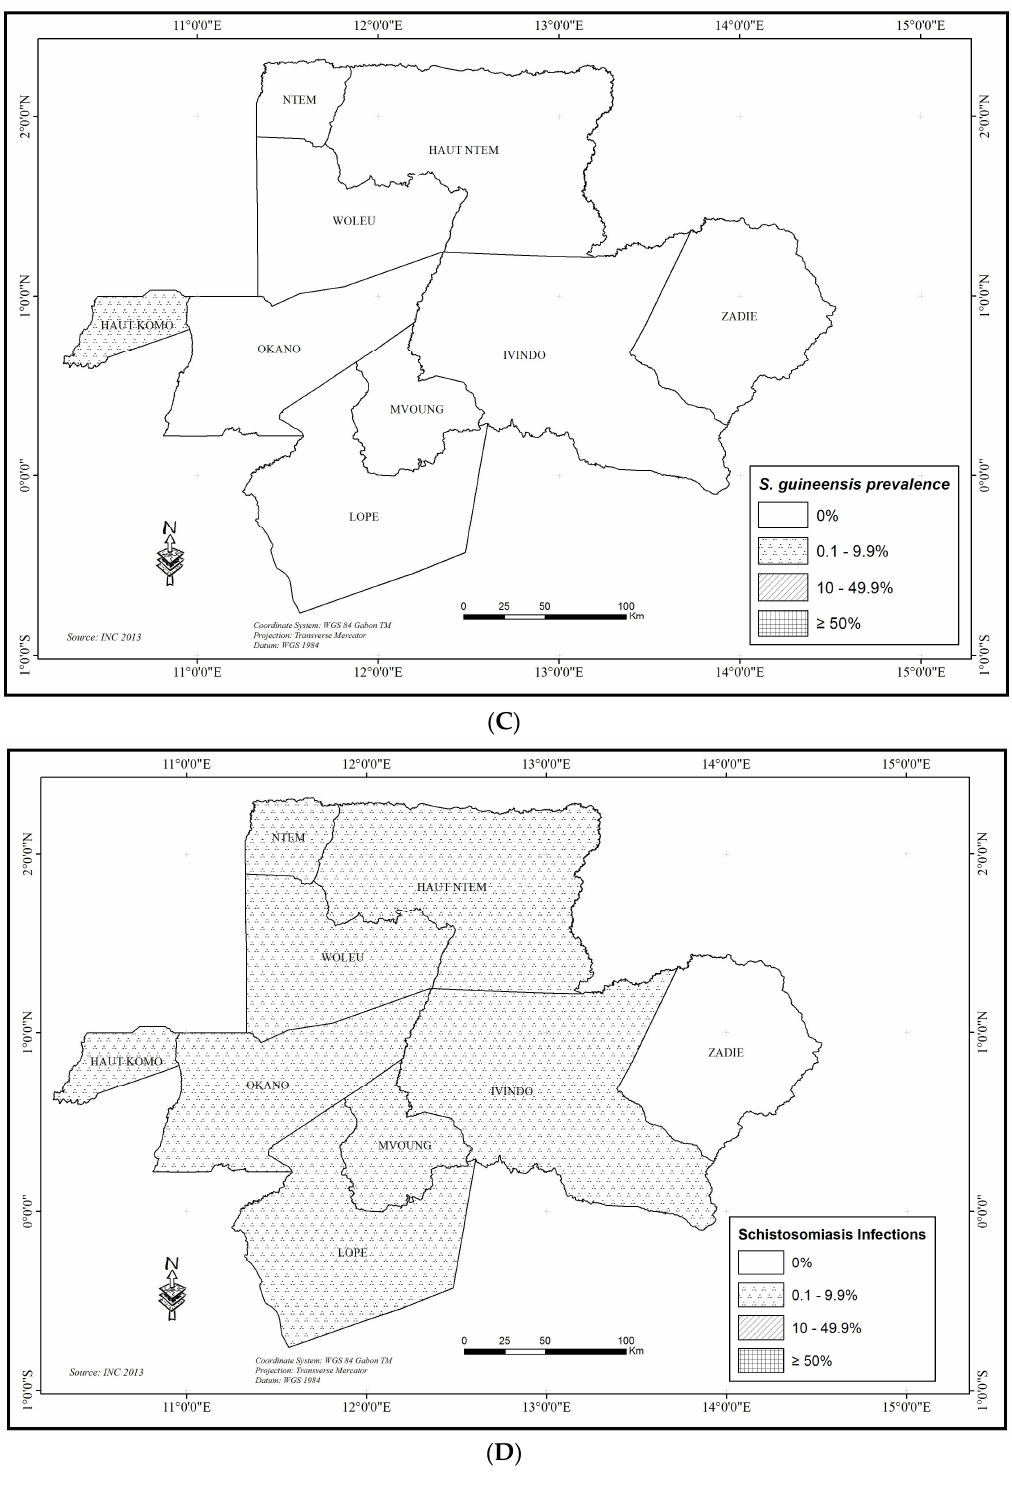
Figure 2. Map of prevalence levels for Schistosomiasis at department scale: ( A ) Schistosoma haematobium ; ( B ) S. mansoni ; ( C ) S. guineensis; and, ( D ) Combined schistosomiasis.